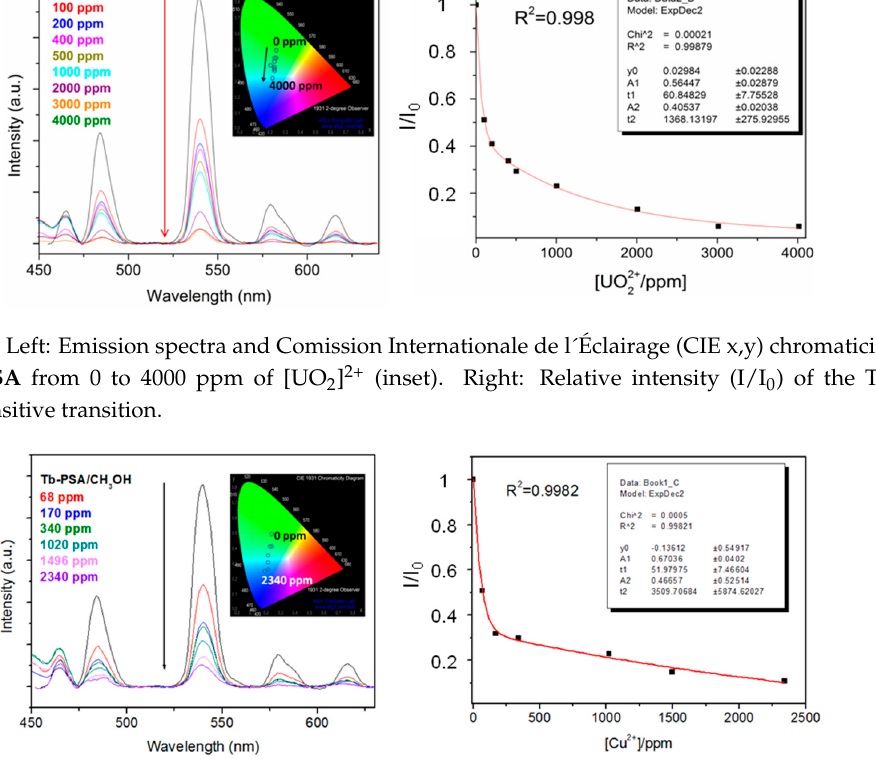
Figure 10. Left: Emission spectra and CIE x,y chromaticities of Tb-PSA from 0 to 2340 ppm of Cu 2+ . Right: Relative intensity (I/I 0 ) of the Tb 3+ hypersensitive transition.